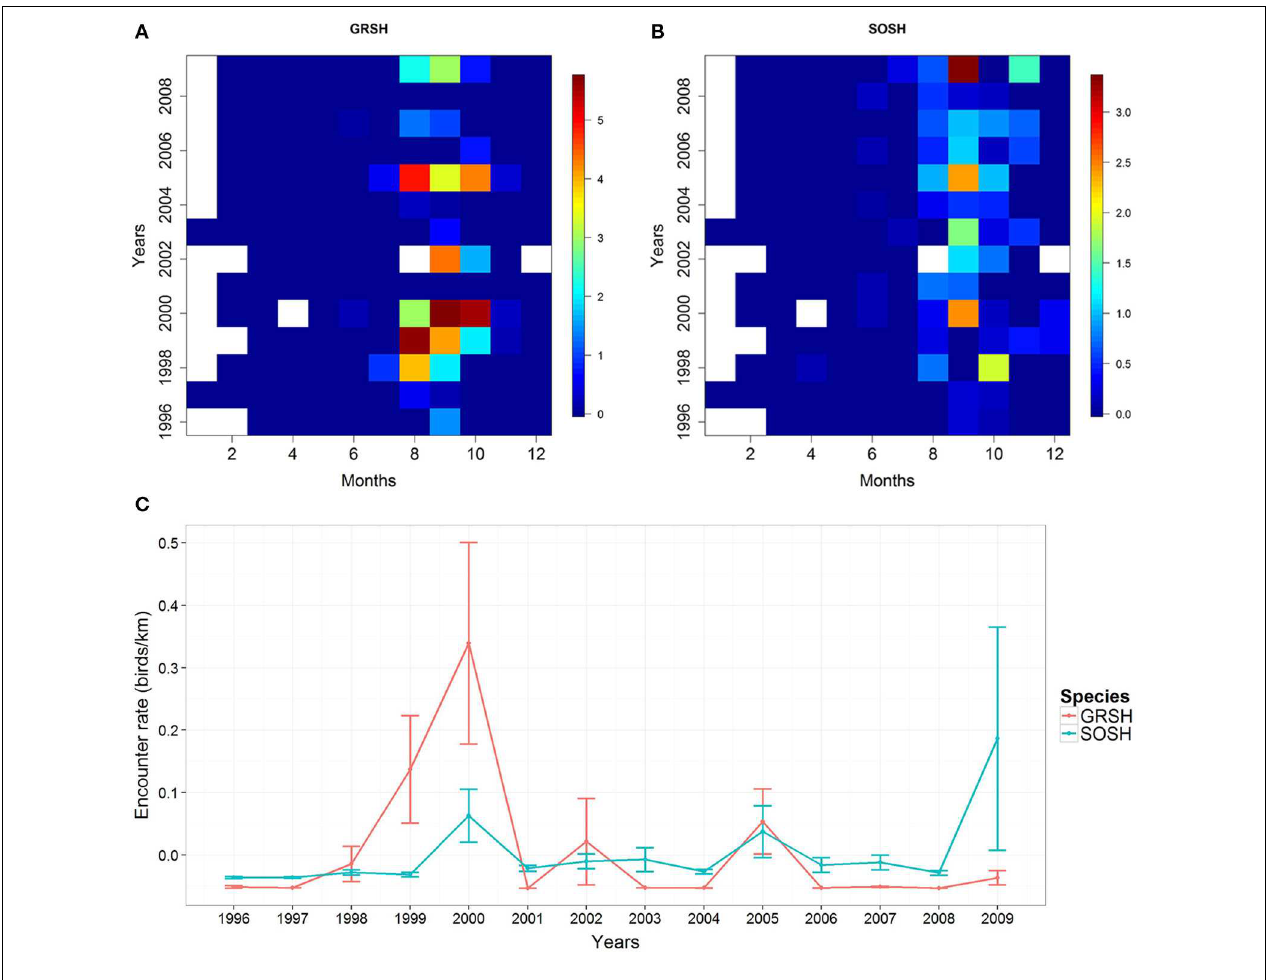
FIGURE 2 | Temporal trends of log-transformed encounter rate (ER, number of birds/traveled km) for (A) great shearwaters (GRSH) (B) sooty shearwaters (SOSH) in the Bay of Biscay and (C) Decadal